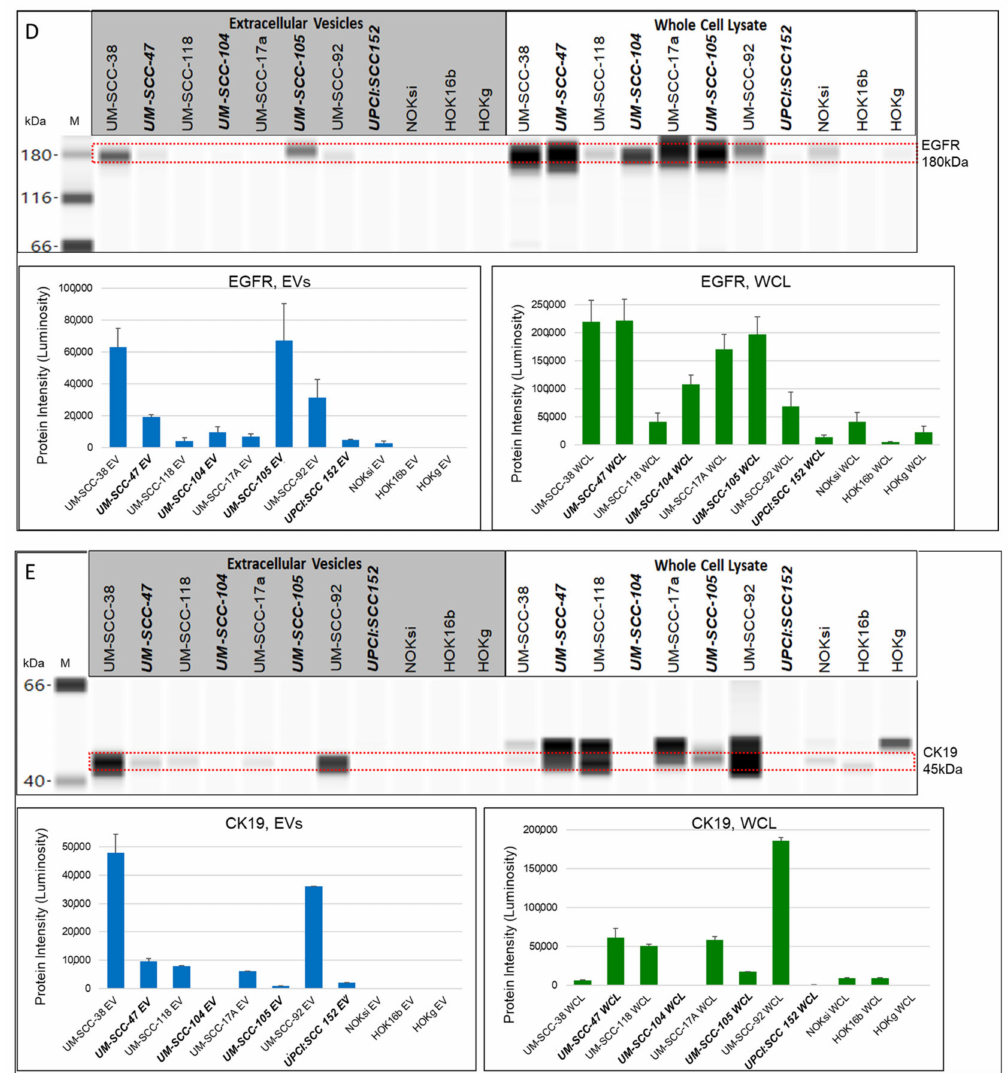
Figure 7. Wes protein gel and quantitative luminosity for extracellular vesicles and whole cell lysates from HNSCC, normal keratinocyte, and transformed cell lines. ( A ) Tenascin detected at 266 kDa, 1:200 antibody dilution, 0.5 µ g/ µ L protein; ( B ) HLA-A detected at 54 kDa, 1:400 antibody dilution, 0.25 µ g/ µ L protein; ( C ) E-cadherin detected at 120 kDa, 1:250 antibody dilution, 0.5 µ g/ µ L protein; ( D ) EGFR detected at 180 kDa, 1:100 antibody dilution, 0.25 µ g/ µ L protein; and ( E ) CK19 detected at 45 kDa, 1:100 antibody dilution, 0.25 mg/mL protein. Bold italics: